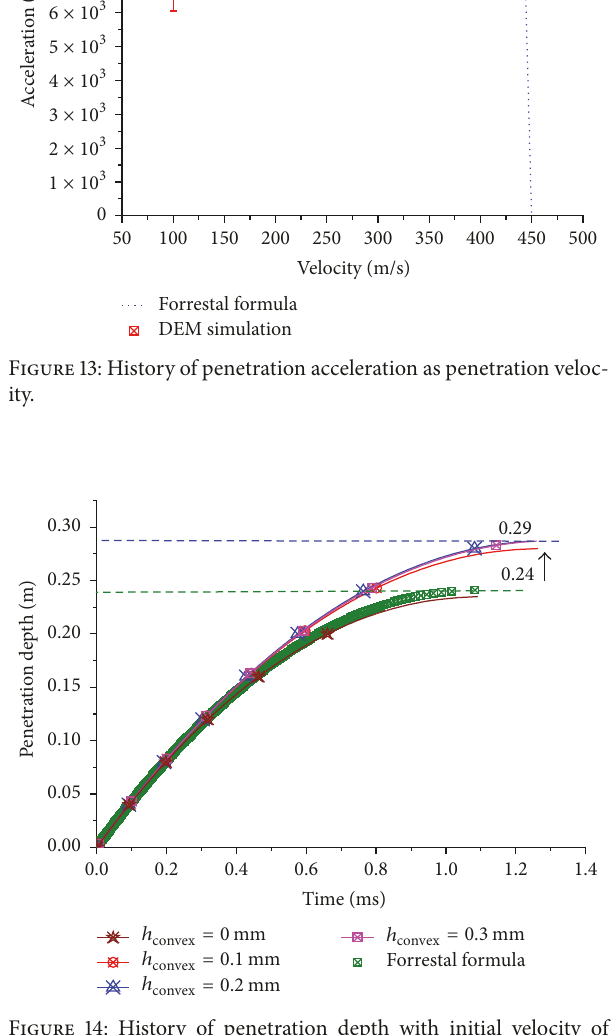
Figure 14: History of penetration depth with initial velocity of 450 m/s.